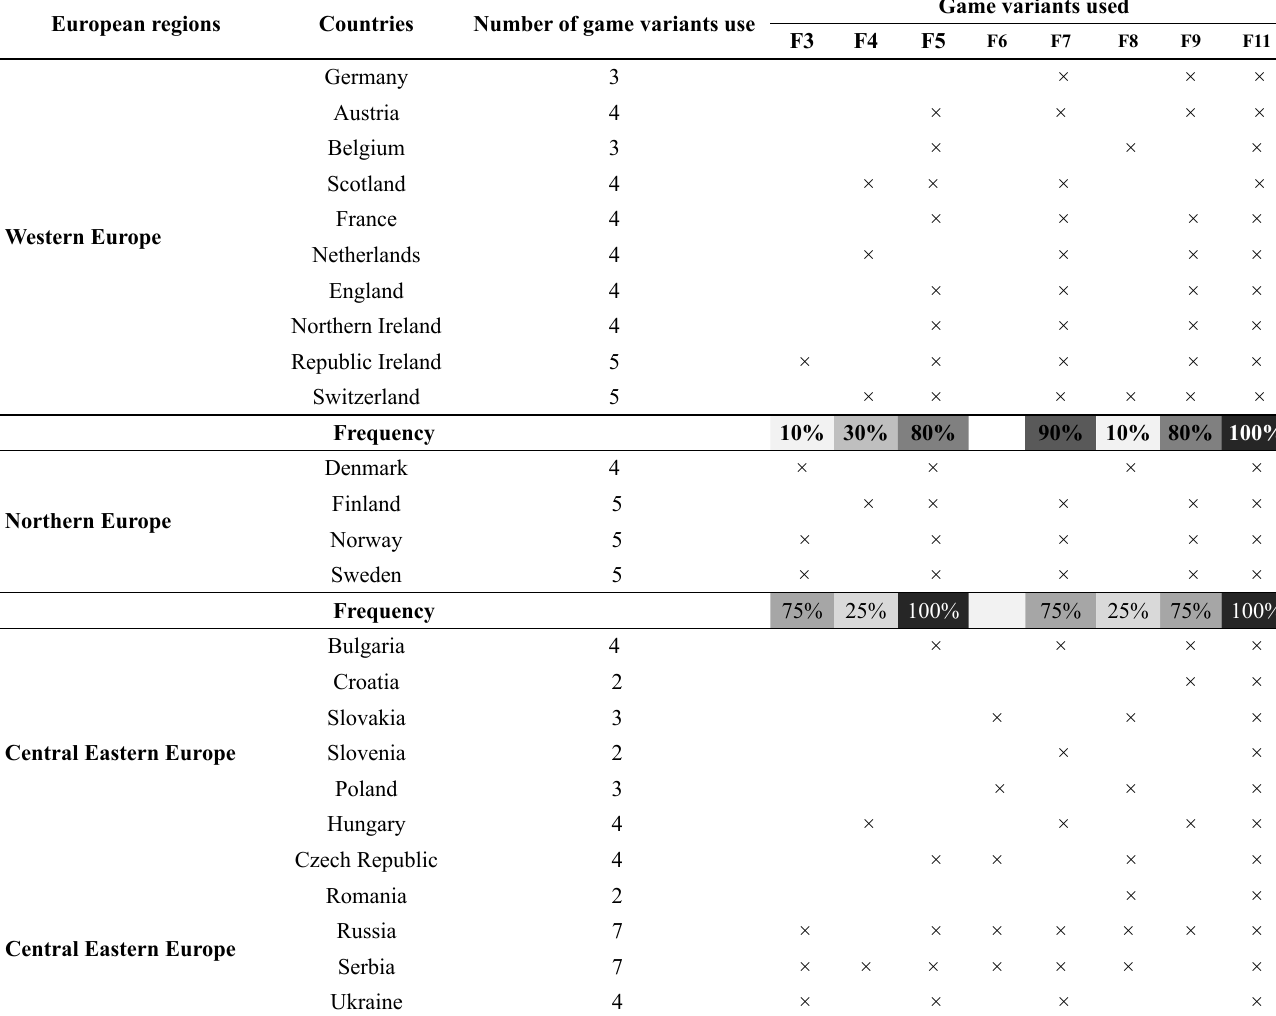
Table 1. Frequency and type of game variants used by European countries along youth competition stages European